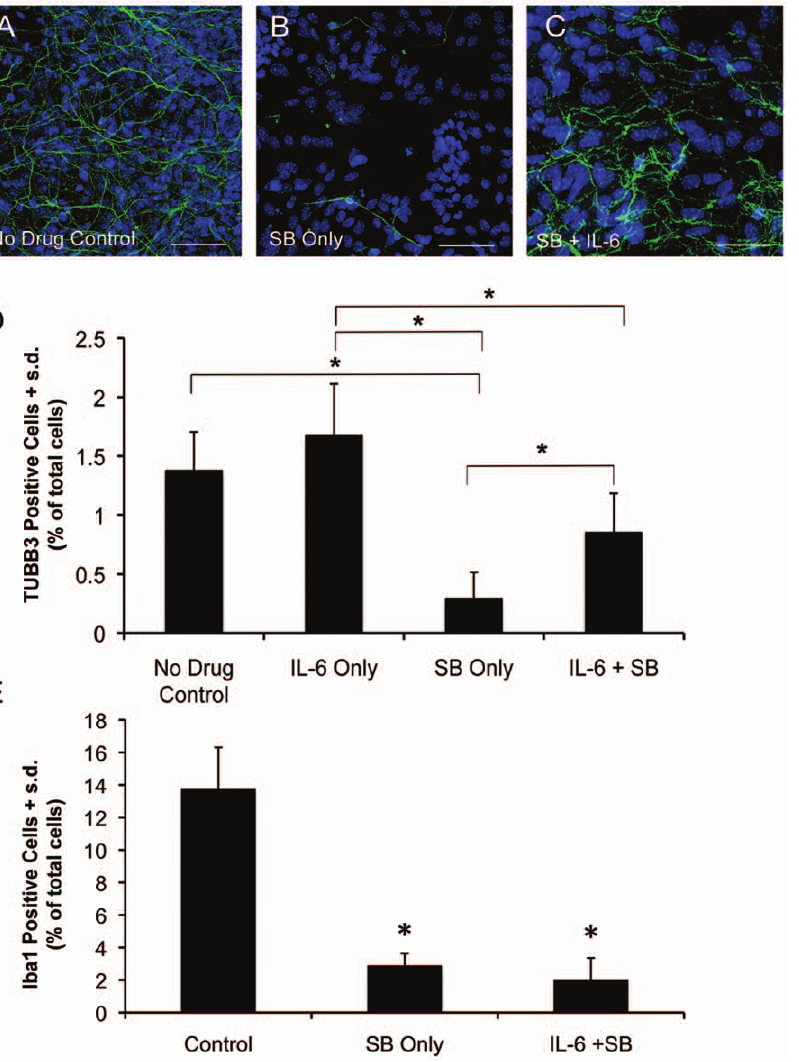
Figure 11. Interleukin-6 (IL-6) treatment partially rescues the effect of HDACi treatment on midbrain neurons. (A) Neurons in an untreated control midbrain culture. (B) Numbers and morphology of midbrain neurons are attenuated following 48 hours of treatment with 50 mM SB. (C) Co-treatment of midbrain cultures with 50 mM SB and IL-6 for 48 hours results in a rescue of the effects of HDACi on neurons. (D) Quantification of the ability of IL-6 to rescue the effects of SB treatment on TUBB3 positive midbrain neurons. Bars represent the mean + s.d. (n=6) for all groups. Asterisk (*) indicates treatment groups showing significant differences using a one-way ANOVA and a post hoc Tukey-Kramer MSD test. (E) IL-6 treatment does not rescue the effects of HDACi on Iba1 positive microglia. Asterisk (*) indicates treatment groups that are significantly different (p , 0.05) from no drug control group as determined by an unpaired Student’s t-test. Bar graph represents the mean + s.d. (n=4). TUBB3 (green), DAPI (blue). Scale bars=50 m M.